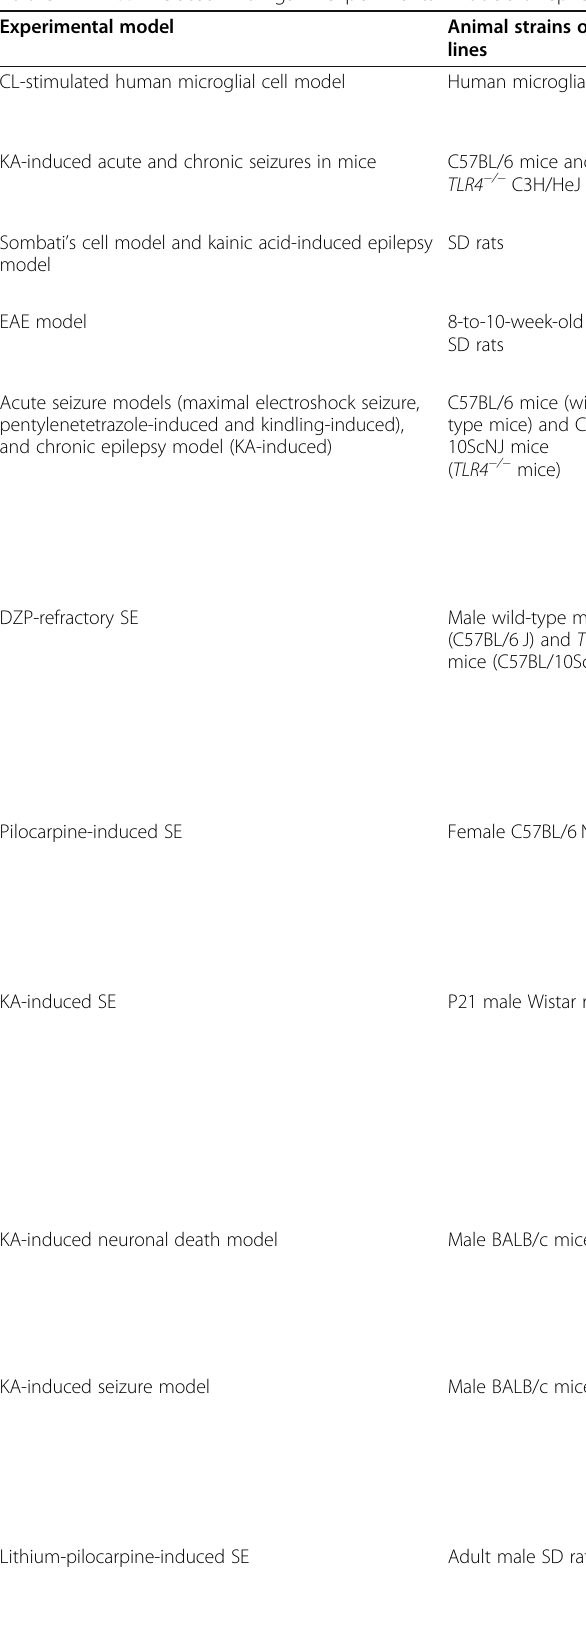
Table 2 HMGB1-related findings in experimental models of